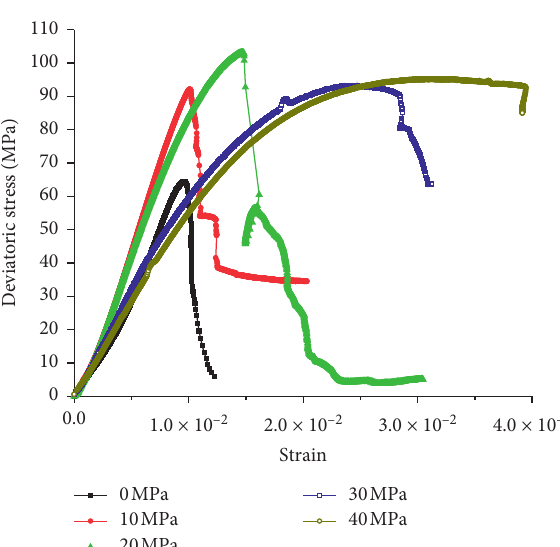
Figure 3: Stress-strain curves of triaxial compression samples.